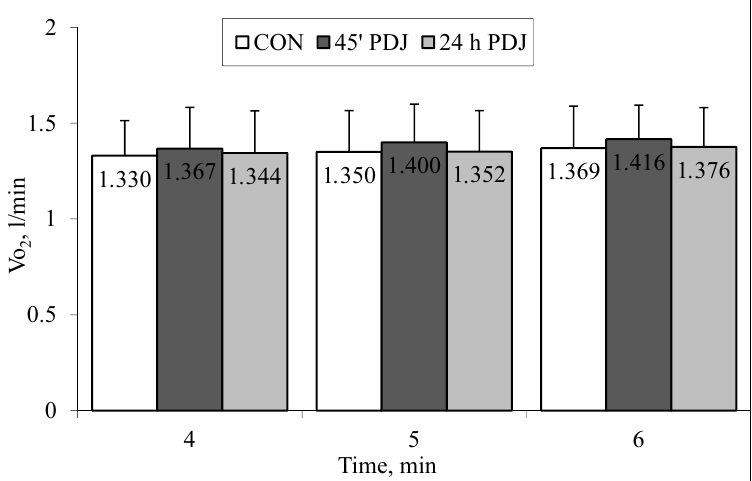
oV & ) during moderate cycling exercise 2